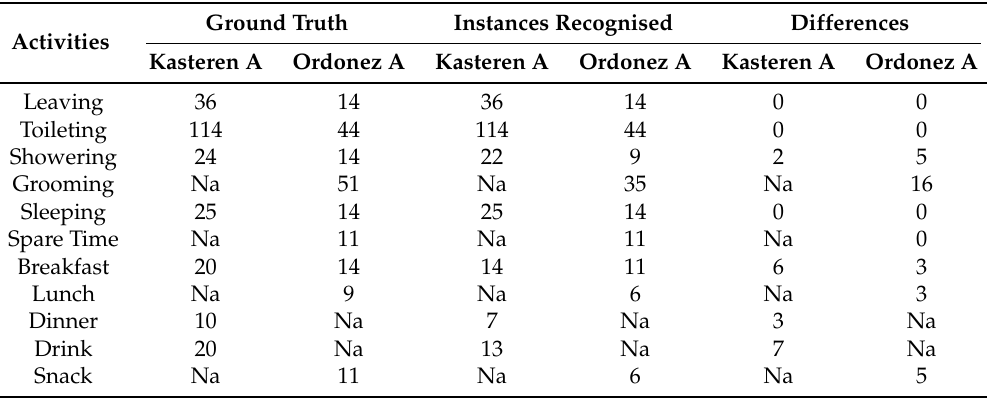
Table 11. Summary of correctly recognised activity instances for Kasteren and Ordonez